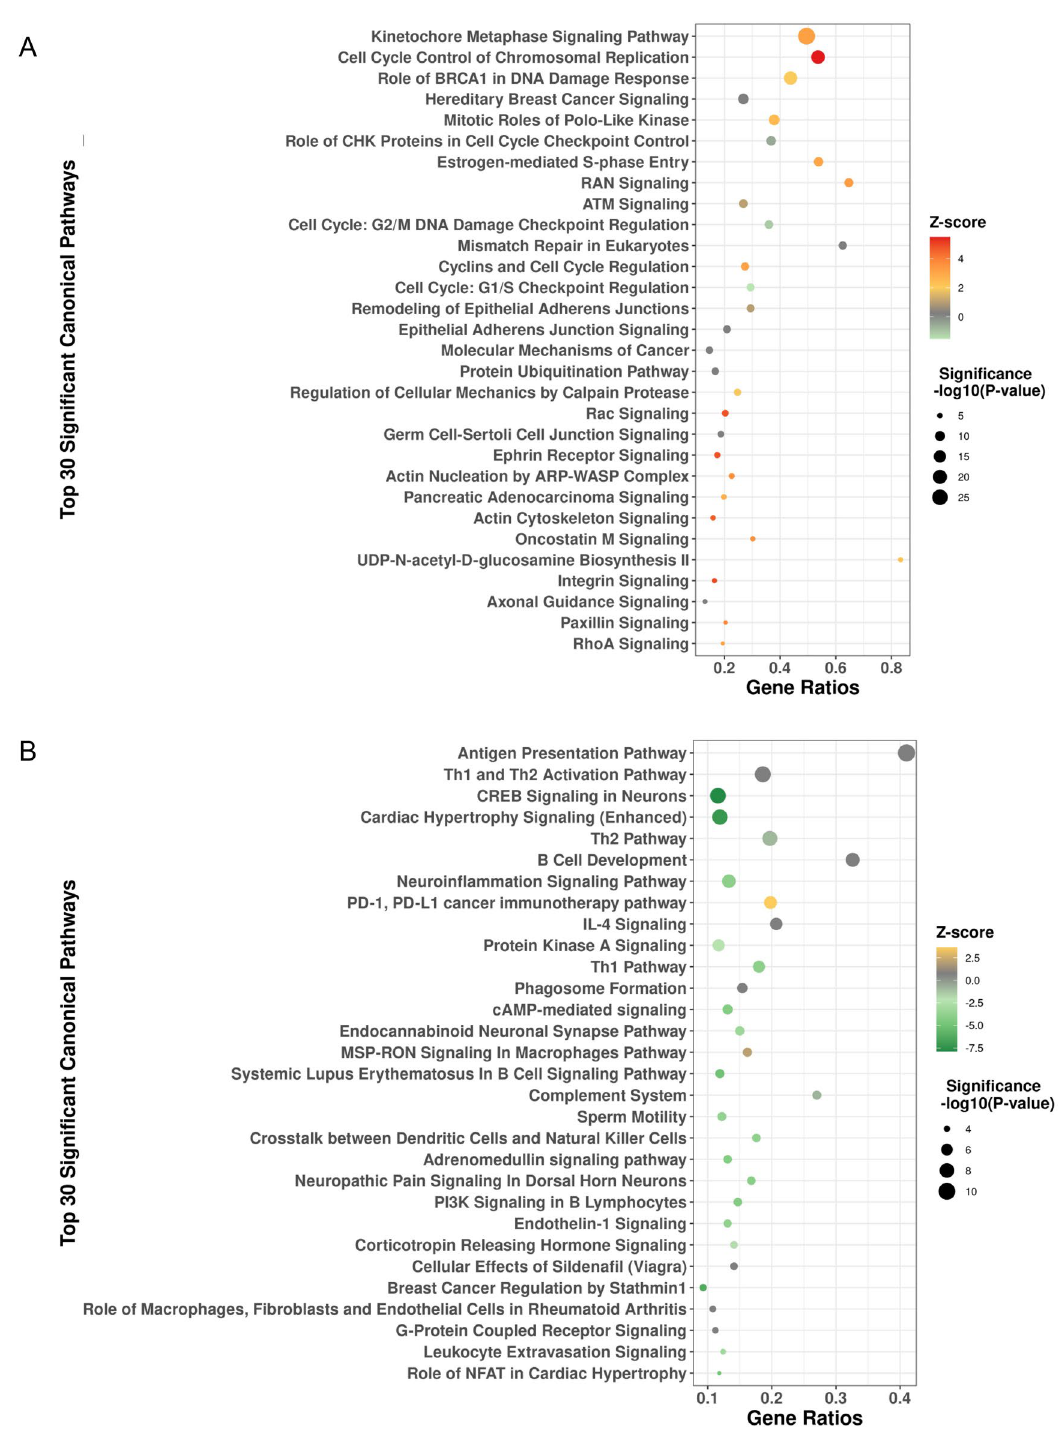
Figure 4. Pathway analysis for differential gene expression heatmap clusters 2 and 3. The top 30 pathways involved in the differential expression of genes in heatmap cluster 2 and 3 are shown in (A) and (B) respectively. Ratio on the x-axis refers to the number of differentially regulated genes in the dataset relative to the total number of pathway genes. The size of each dot represents significance (− log10( P -value)); the color of each dot represents the Z-score. A positive Z-score indicates that the observed gene activity positively correlates with predicted pathway member up/down regulation patterns; a negative Z-score indicates